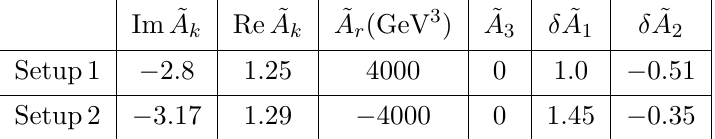
Table 1 . Dimensionful parameters of the model (all quantities in GeV except ~ A r ).